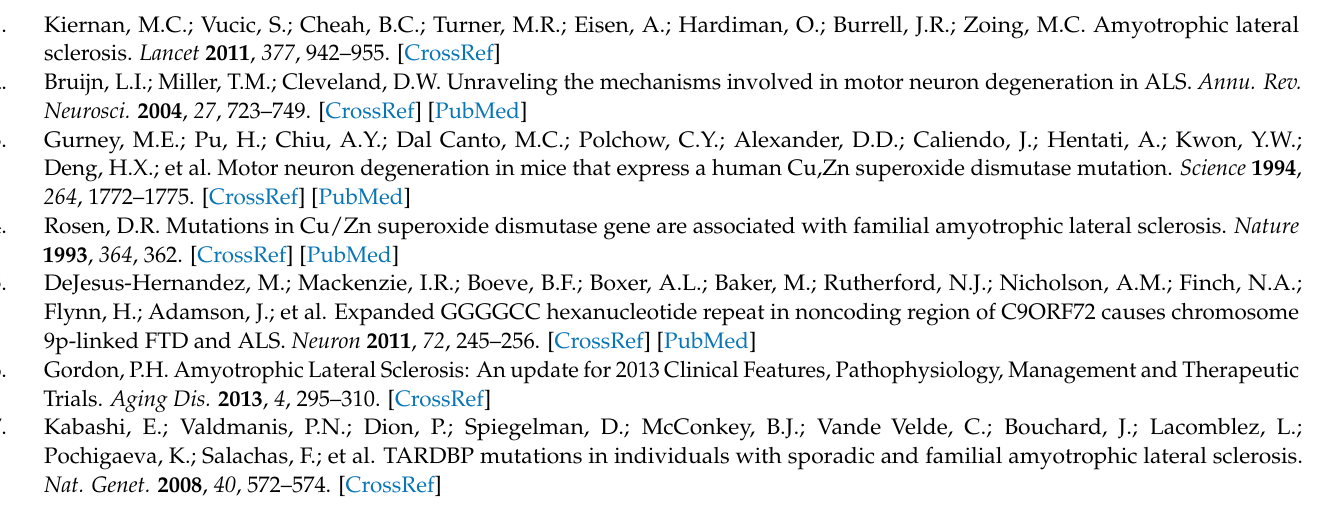
Table S1a: Percentage of hMSCs per production; Table S1b: Human specific primers for